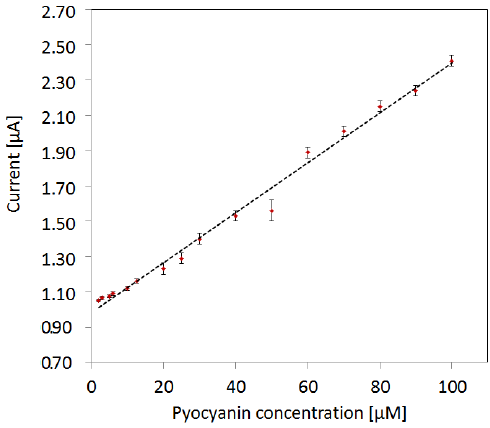
Figure 5. Detection limit of pyocyanin using max peak currents of cyclic voltammograms. The limit of detection (LOD) is 2 µM. The linear fit to peak currents vs. pyocyanin concentration has a linearity of 0.991. The error bars represent the standard deviation from measurements in the four different backgrounds of mix concentrations and in no mix background.